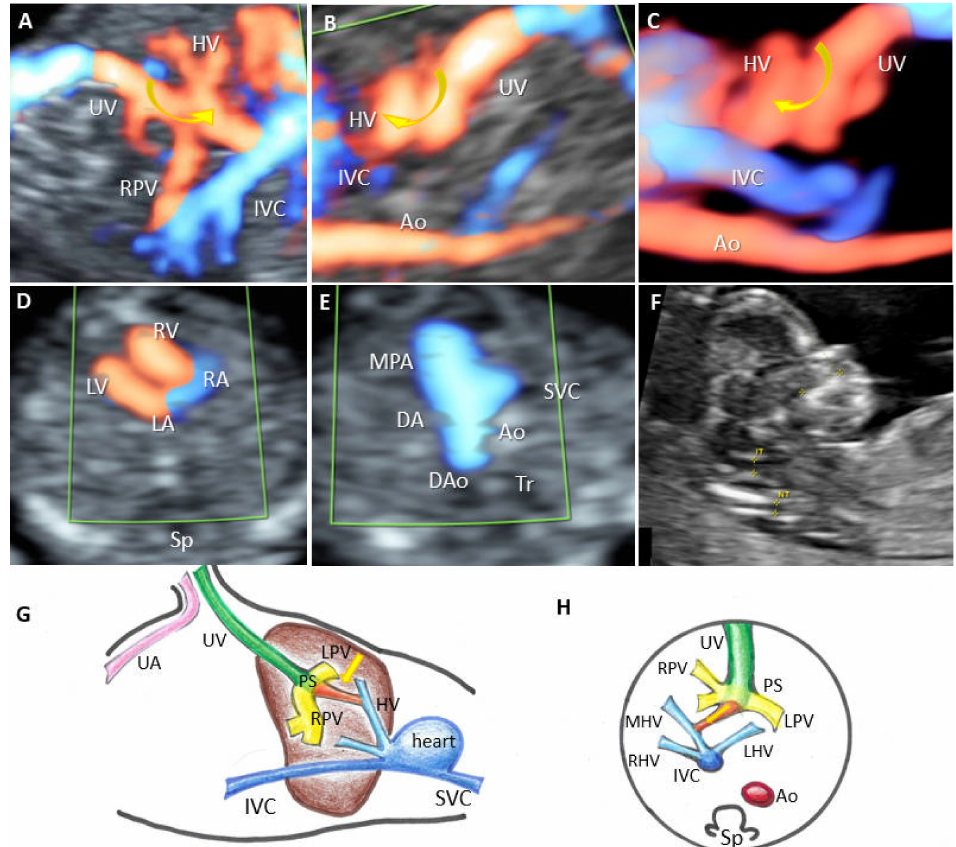
Figure 4. UPSVS type II with hepatic vein drainage of the umbilical vein at 13 weeks of gestation (Case 11). ( A , B ) In the sagittal plane, color Doppler imaging shows the umbilical vein draining through a short ductus venosus-like vessel (arrow) into the hepatic. ( C ) Four-dimensional STIC reconstruction, showing in the sagittal plane the abnormal drainage of the umbilical vein (blue circle). ( D ) Four-chamber view. During diastole, flow is visualized entering from the right and left atria (RA, LA) into the right and left ventricles (RV, LV), and the interatrial and interventricular septum separates the flows. ( E ) Normal “V-sign” with pulmonary artery, ductus arteriosus, and transverse aortic arch. ( F ) Midsagittal plane of the fetal head and upper thorax, showing normal appearance of the first-trimester genetic markers: nuchal translucency (NT) and nasal bone. ( G , H ) Schematic diagram of type II shunt. ( G ) Sagittal and ( H) axial plane with abnormal course of umbilical vein draining into the hepatic vein through a ductus venosus-like vessel. SVC, superior vena cava; Ao, aorta; MPA, main pulmonary artery; DA, ductus arteriosus; Dao, descending aorta; Tr, trachea. IVC, inferior vena cava; Sp, spine; RA, right atrium; LA, left atrium; RV, right ventricle; LV, left ventricle; UV, umbilical vein; HV, hepatic vein; MHV, medial branch of the hepatic vein; RHV, right hepatic vein; LHV, left hepatic vein; Ao, aorta; RPV, right portal vein; LPV, left portal vein; PS portal sinus; RPV, right portal vein; DV, ductus venosus; UA, umbilical